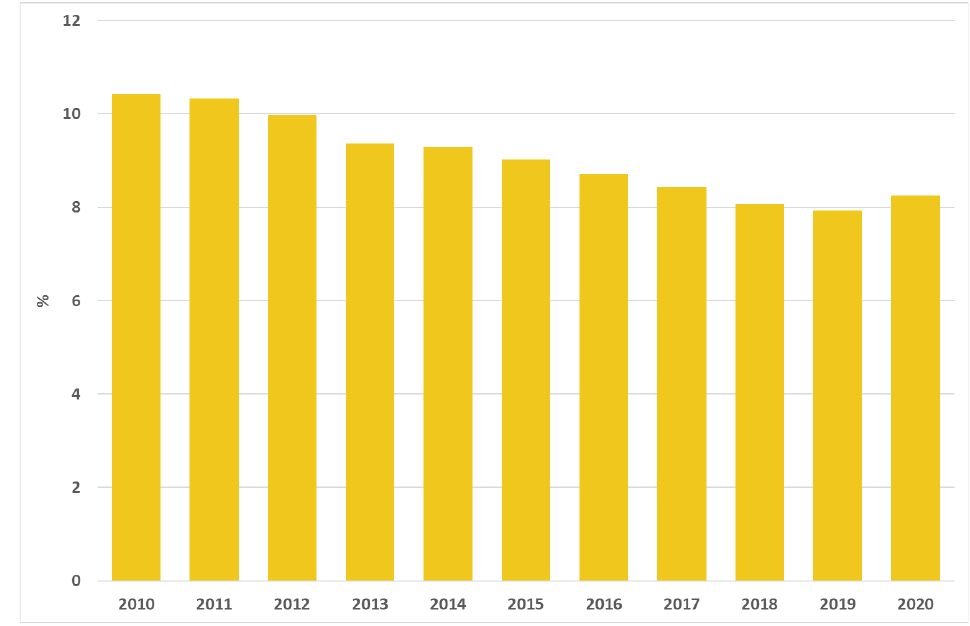
Figure 3. 30-day mortality rates after acute myocardial infarction. Italy, 2010–2020.